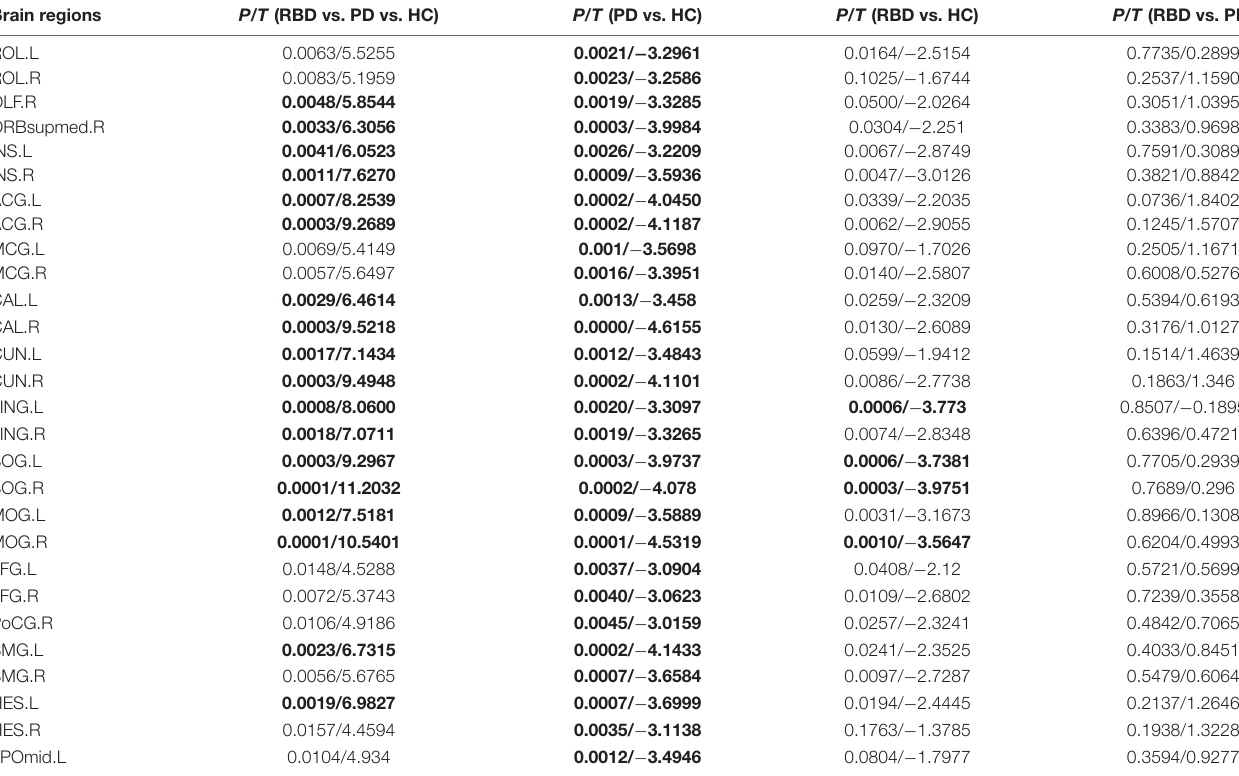
TABLE 3 | Alterations of Nodal Efficiency among idiopathic rapid eye movement sleep behavior disorder (iRBD), Parkinson’s disease (PD), and healthy control (HC). Brain regions P/T (RBD vs. PD vs. HC) P/T (PD vs.